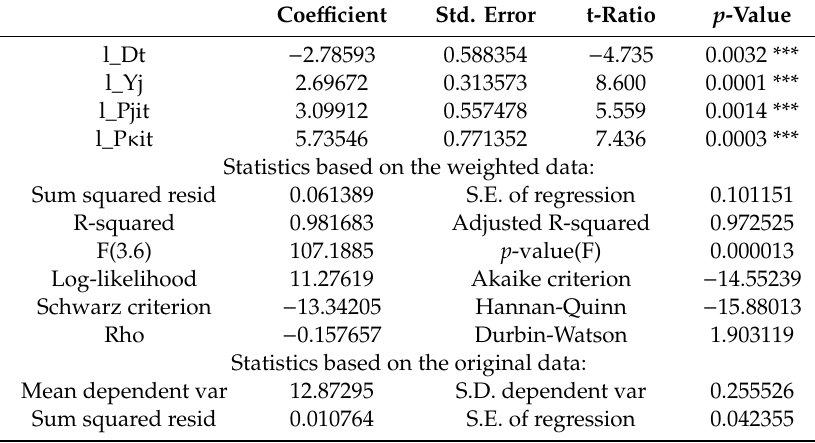
Table 11. FGLS estimation of the total amount of Hungarian tourists in Croatia – final model. Model 2: FGLS, using observations 2009–2018 (T = 10); dependent variable: l_TAji; variable used as weight: